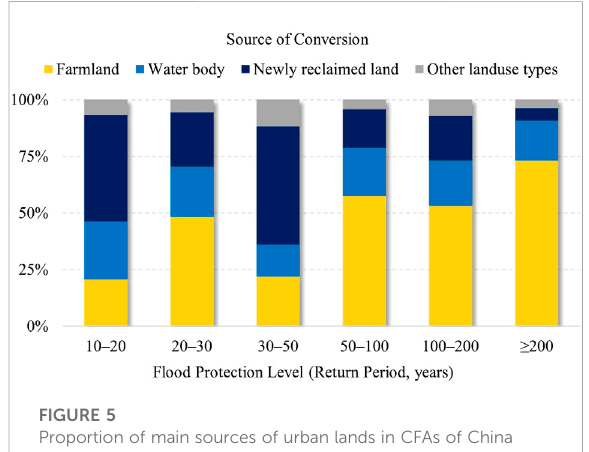
FIGURE 5 Proportion of main sources of urban lands in CFAs of China under different FPLs during 2000 – 2020.